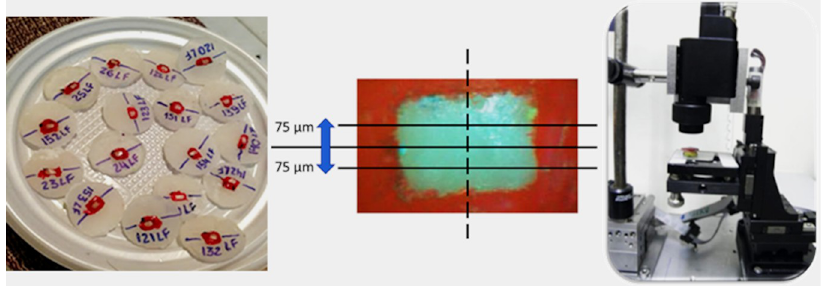
Fig 2. Positioning of samples for OCT measurements. A) Samples embedded in acrylic resin; B) Regions where measurements were performed: at the center of the ROI and 75 μ m from the center in opposite directions; C) OCT probe fixed to prevent changes in measures through the